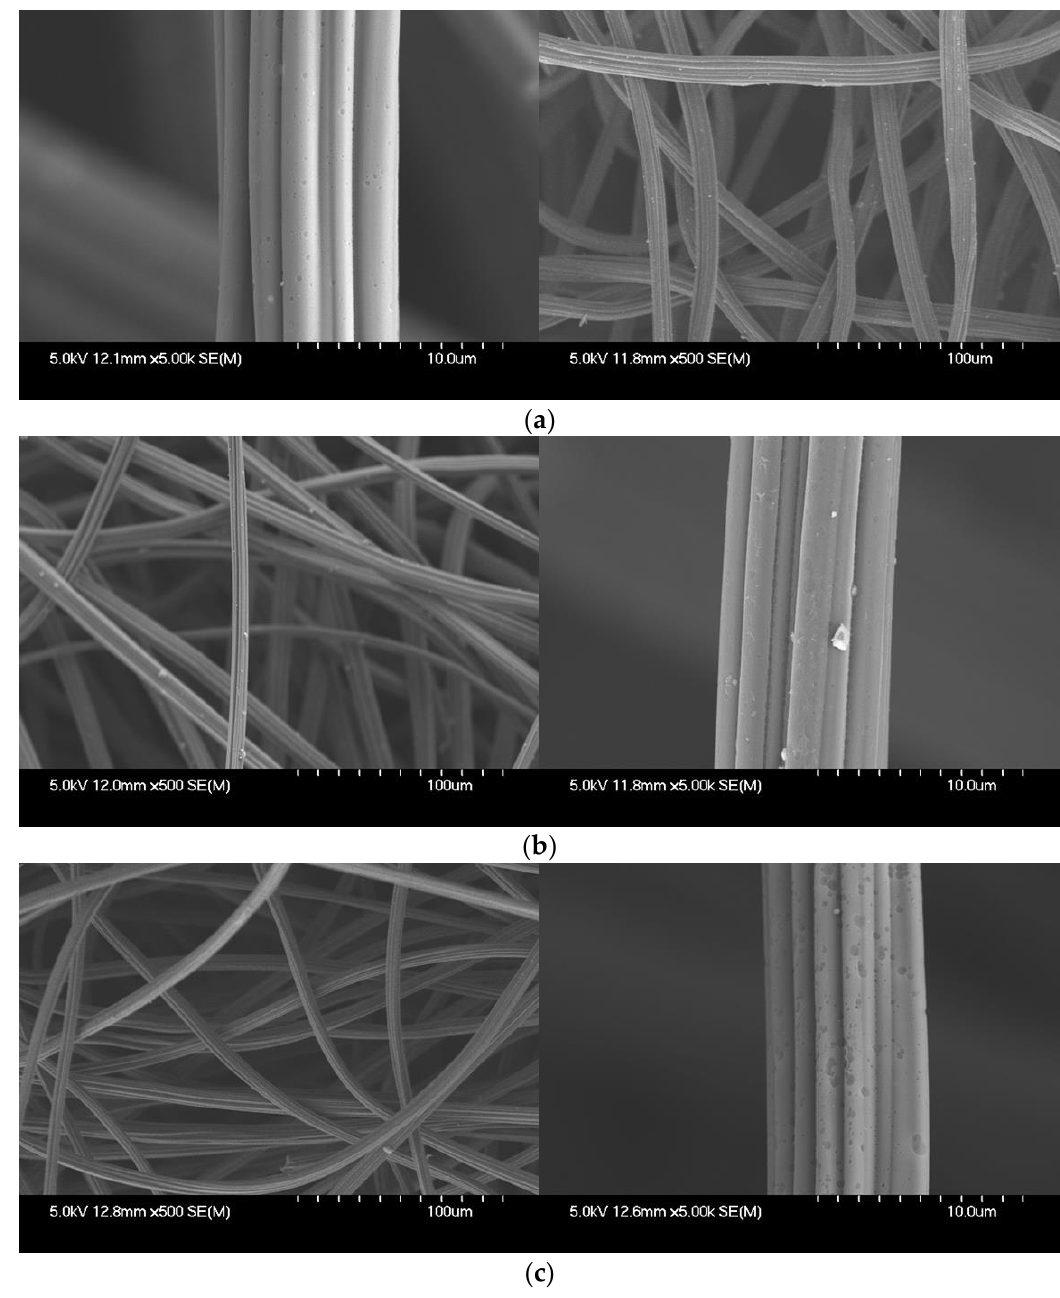
Figure 7. Results of surface morphology of ACFs after ST-CA process obtained via Scanning Electron Microscope (SEM). ( a ) Untreated ACFs, ( b ) ACFs after ST process, ( c ) ACFs after ST-CA process.